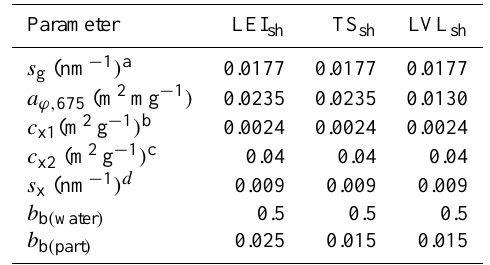
Table 4. Parameters used for light model of Gallegos et al. (2011), Eq. (2): s g = spectral slope of CDOM; a ϕ, 675 = chlorophyll peak absorption; c x1 = baseline non-algal absorption; c x2 = non-algal absorption cross-section; s x = non-algal spectral slope; b b ( water ) = backscattering by water molecules; b b ( part ) = backscattering by particulates.